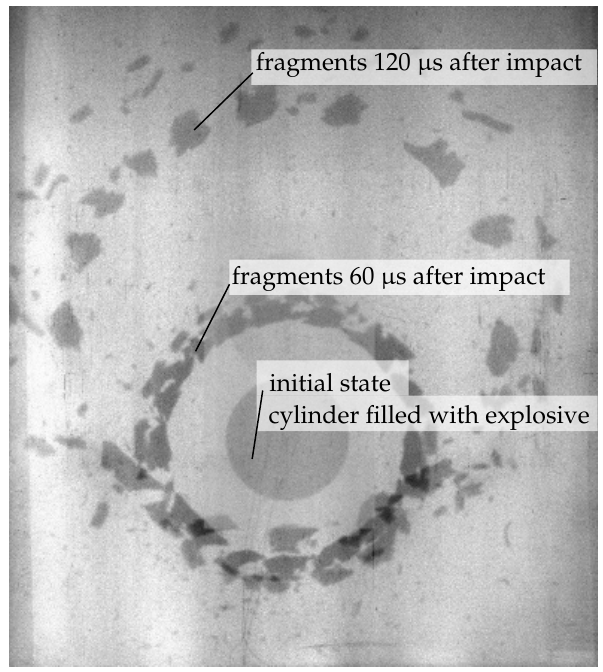
Figure 5. Double-exposed X-ray visualization of ring expansion for 1:2 aspect ratio (exposures 60 µ s and 120 µ s after